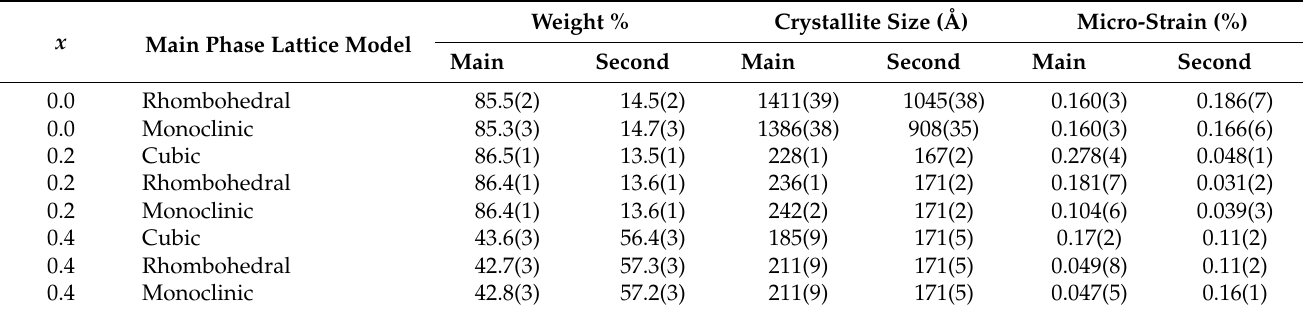
Table 4. Weight percent and microstructural details of individual phases of La 1 − x Ce x CoO 3 , as determined from the Rietveld refinement analysis. Numbers in parentheses are statistical errors of the last significant digit (Main = main phase, Second = Secondary phase).